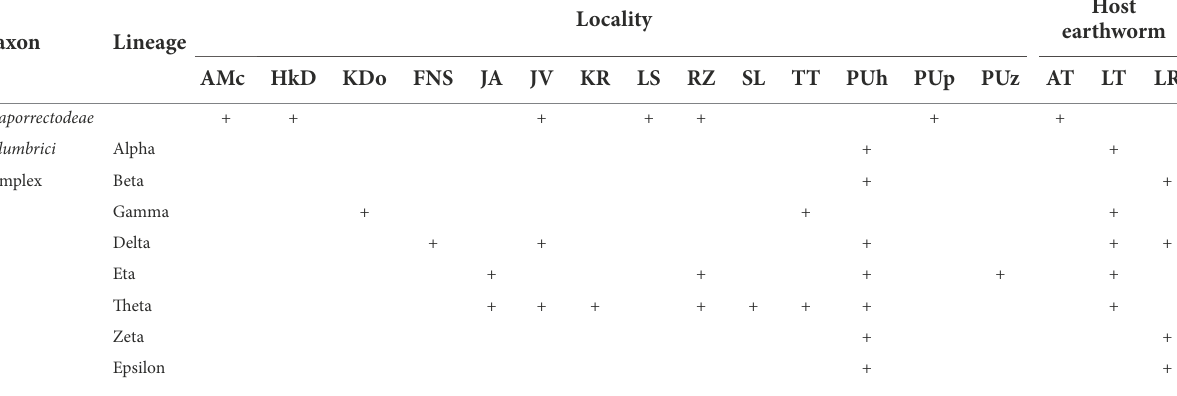
TABLE 1 Distribution of nine mitochondrial lineages of plagiotomids in three earthworm species examined during the course of this study.